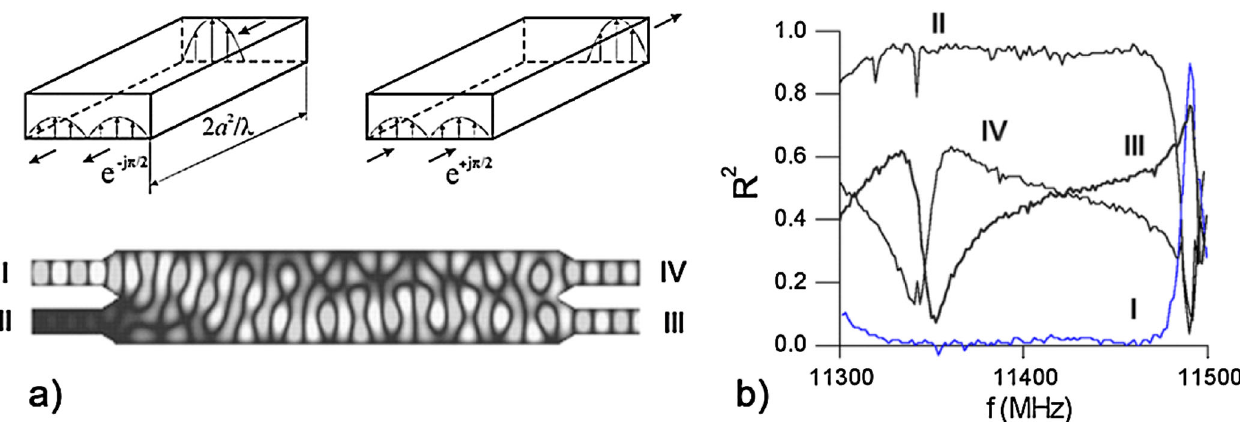
FIG. 6. (Color) Quasioptical 3-dB coupler using the effect of image multiplication: (a) the general concept of operation and instantaneous electric field distribution in the hybrid coupler, with arm I driven and the remaining arms terminated in matched loads; (b) power distribution between arms I to IV in the hybrid coupler (curves I and II are obtained with arms III and IV terminated by reflecting shorts, curves III and IV show the splitting of the incident power from arm I between the two outputs).